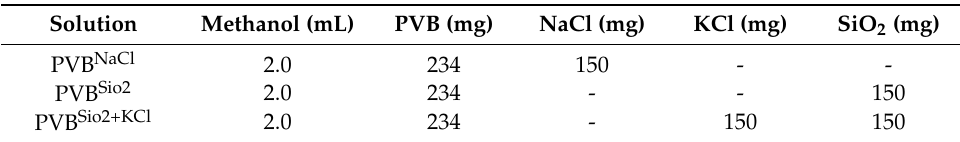
Table 1. Composition of the different polyvinyl butyral (PVB)